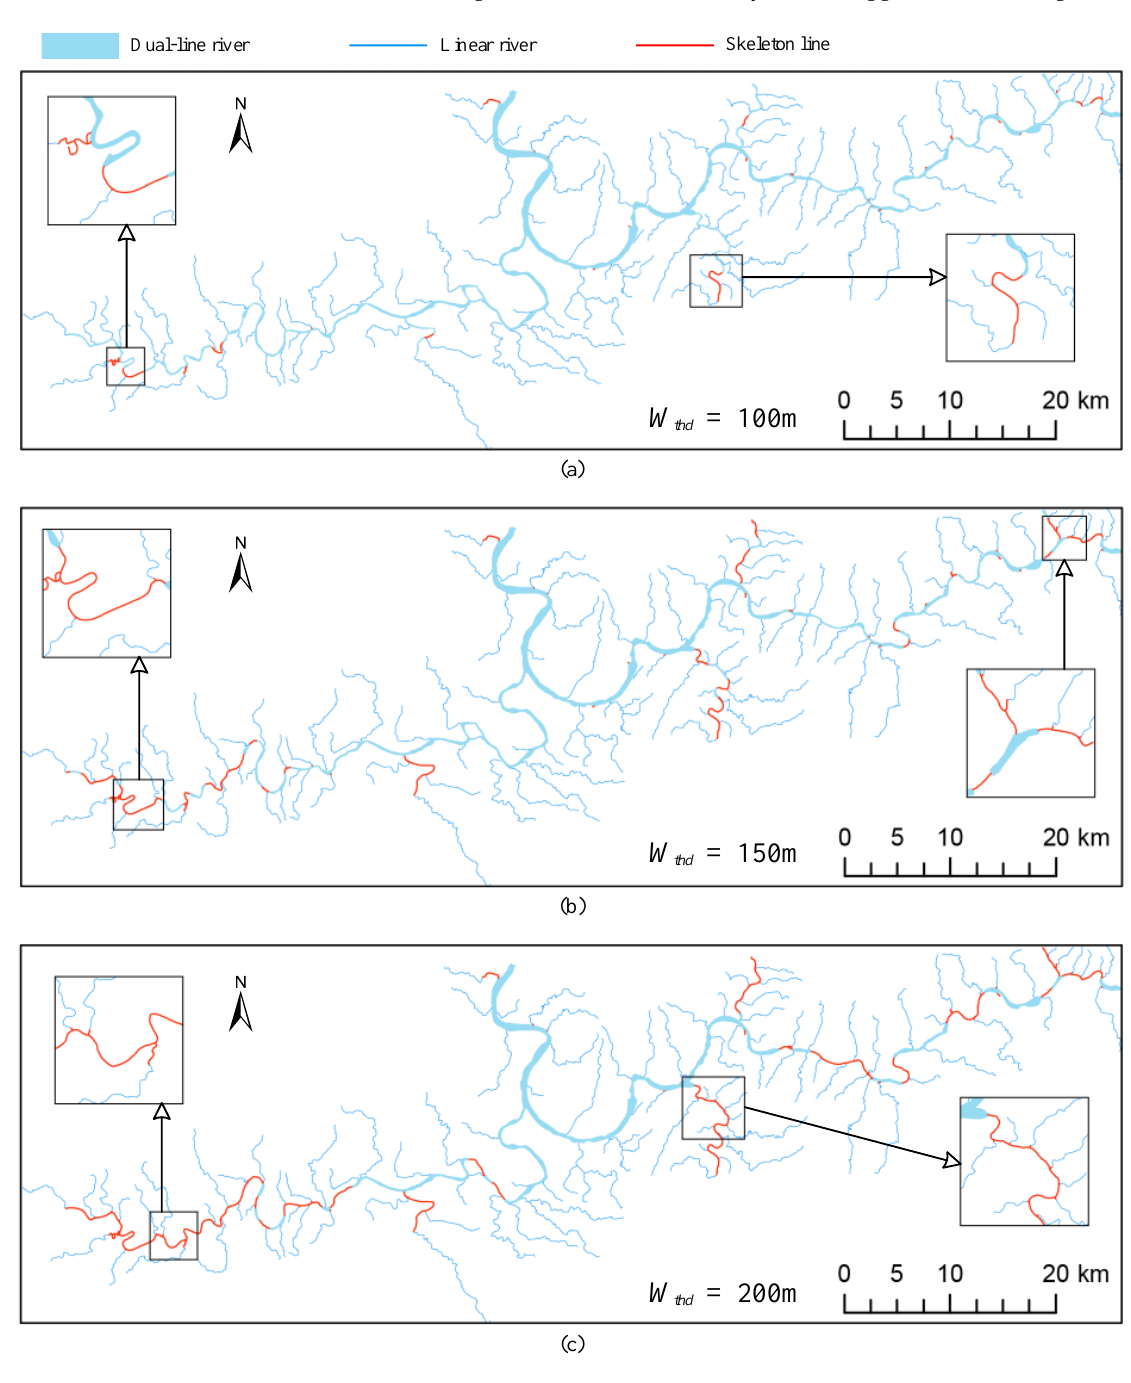
W ; ( b ) =15 0 m W thd thd